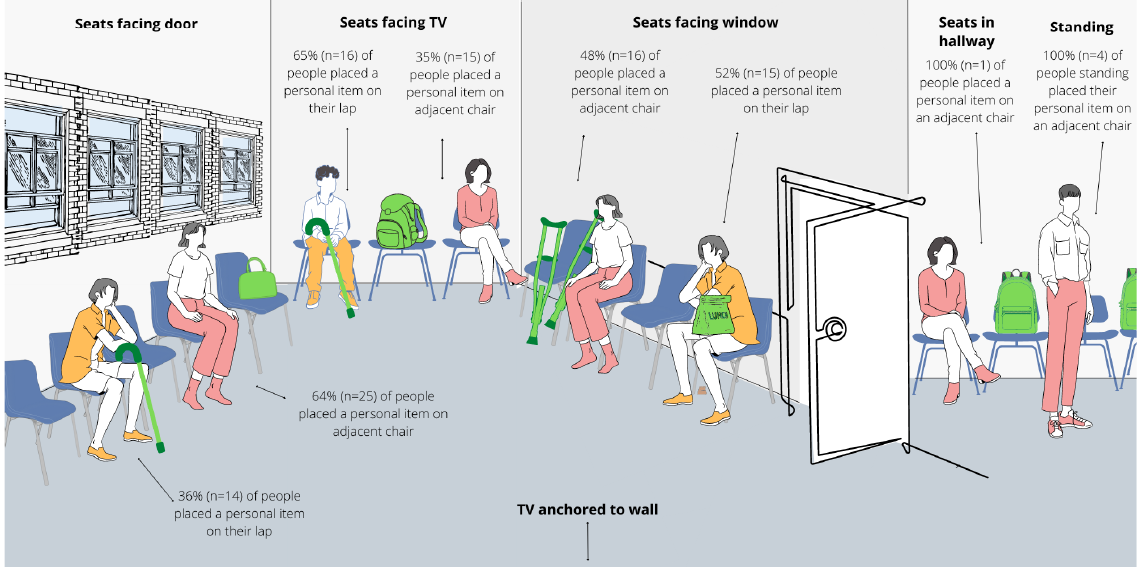
Figure 3. Infographic of how people chose to place their personal items.